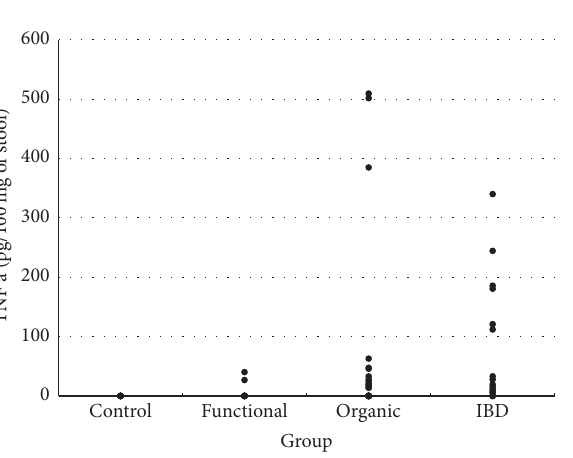
Figure 2: Distribution of fecal tumor necrosis alpha (TNF alpha) levels in the study groups.